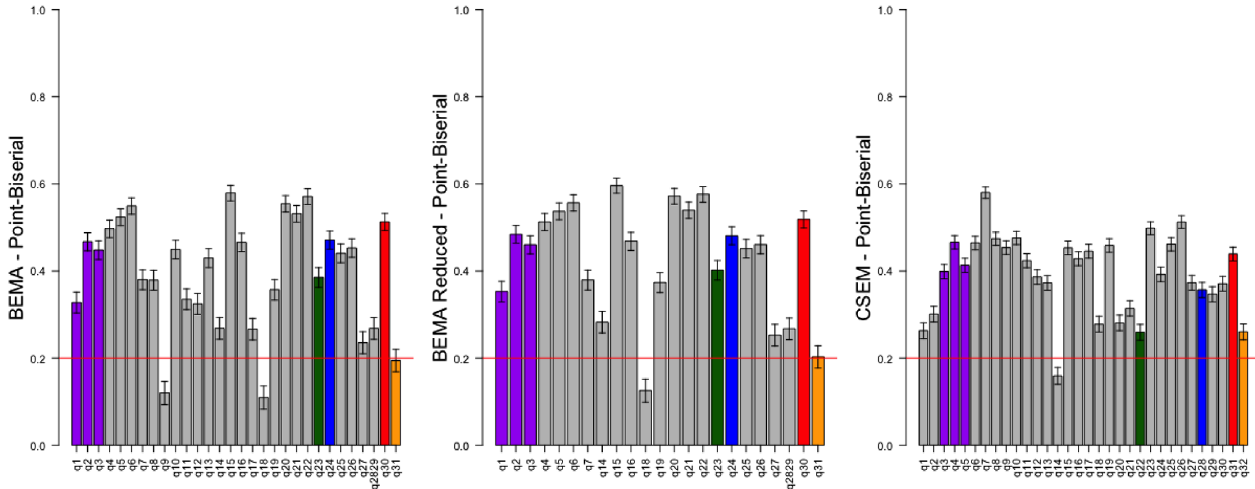
FIG. 5. The point biserial for each of the items in the BEMA and CSEM. The red line is at 0.2, which is an accepted minimum for item point-biserial values. There error bars represents the 95% confidence interval for each of the bins, respectively. The colored bars are the 7 identical items between the BEMA and